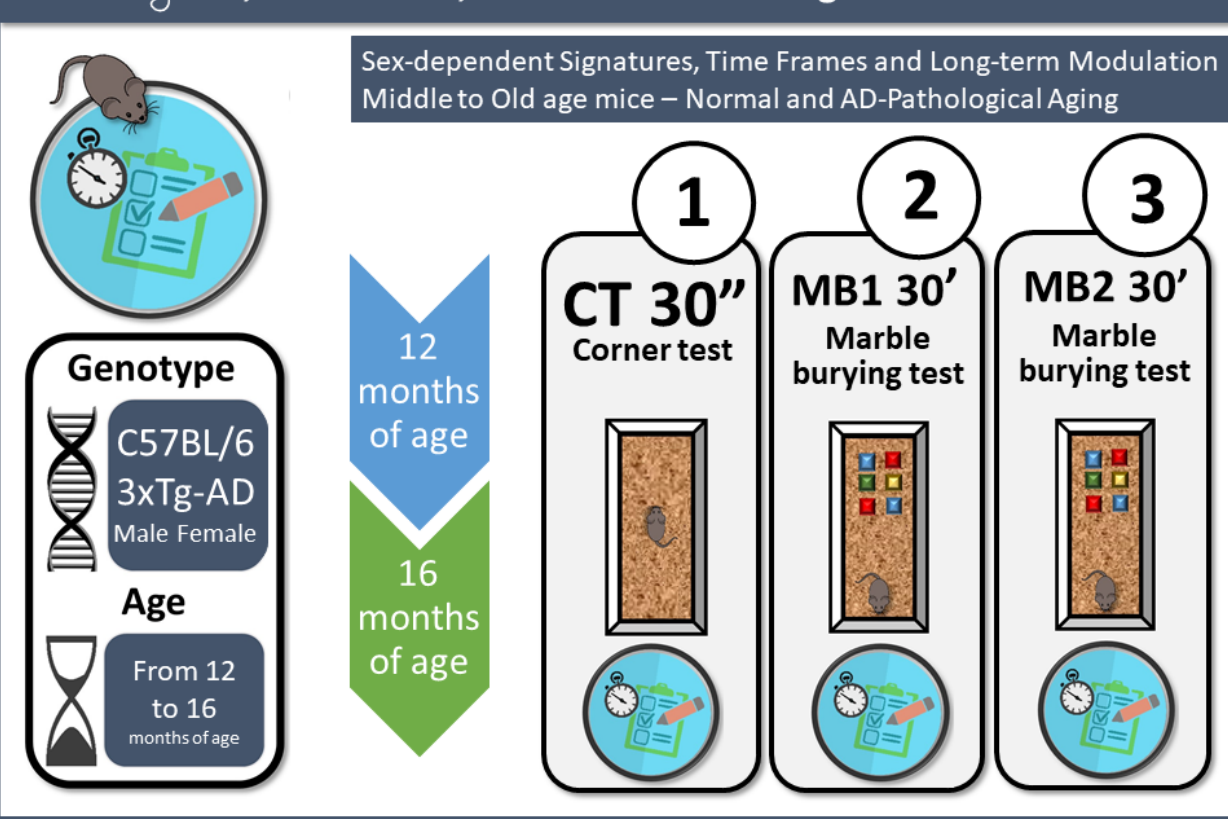
Figure 1. Fine-tuning of the marble burying test by sex, time frame, test–re-test, and longitudinal assessment. Experimental design: a 3-day battery of behavioral tests consisting of a corner test on day 1, a marble burying test on day 2 (MB1), and a repeated test on day 3 (MB2).